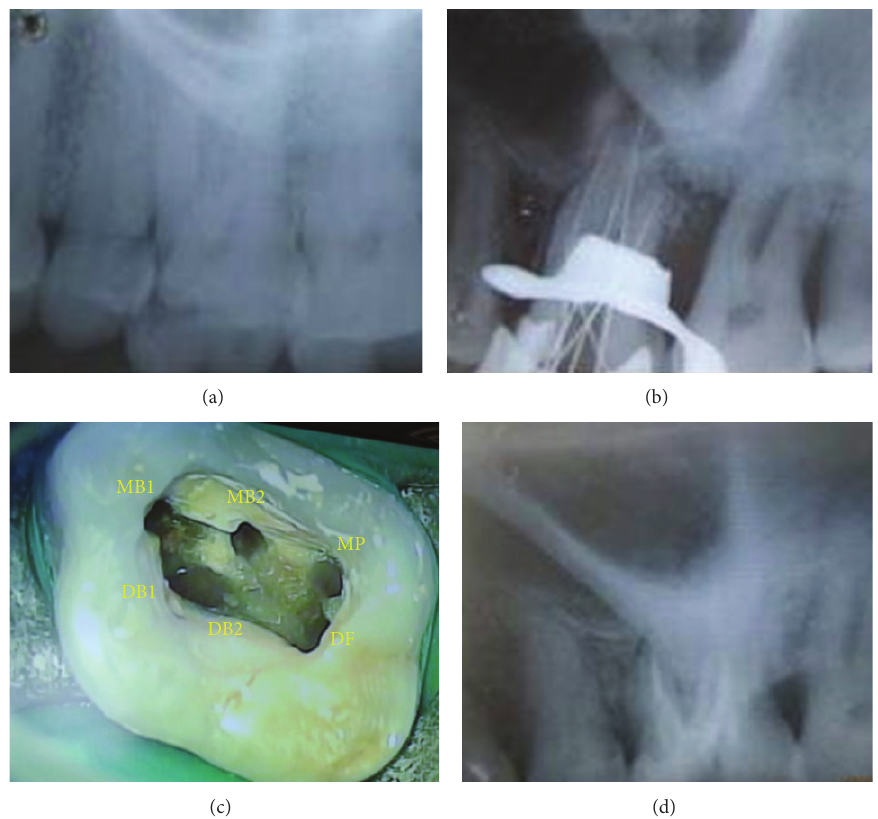
Figure 1: (a) Preoperative radiograph. (b) Working length radiograph showing multiple canals. (c) Access opening of the tooth showing multiple orifices. (d) Postobturation